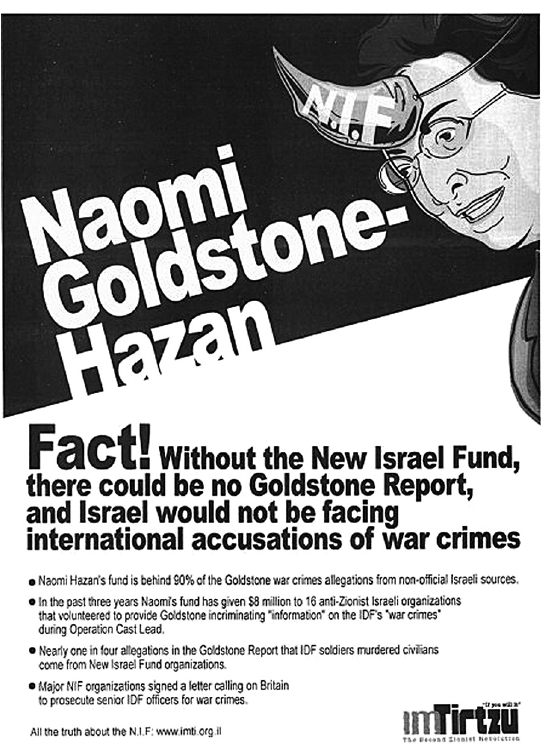
Figure 1: Im Tirzu ’ s personal attacks on Naomi Chazan (Misspelled as Hazan). The Hebrew word for foundation (keren) also means an animal ’ s